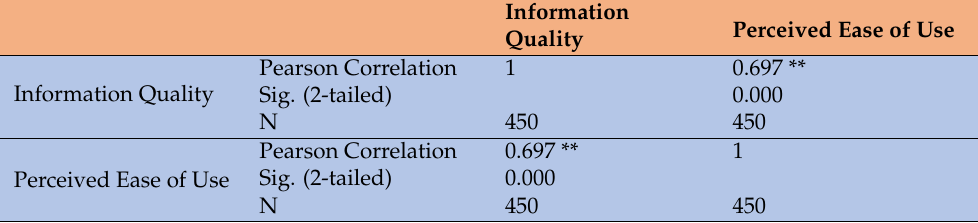
Table 8. Results of the correlation analysis for hypothesis 3 (H3).